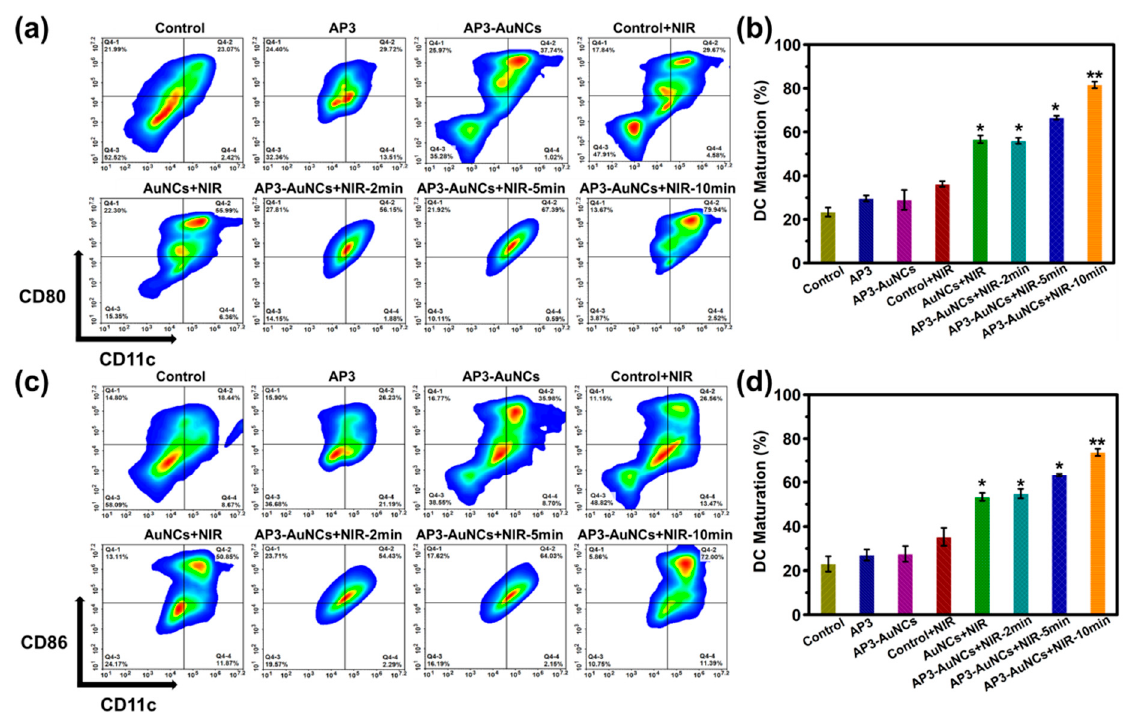
Figure 8. Flow cytometry expression of ( a – b ) CD11c CD80 ( c – d ) CD11c CD86 on mature DCs surface after feeding AP3, AuNCs and AP3-AuNCs. Two-tail Student’s test was used. * p < 0.05, ** p < 0.01.